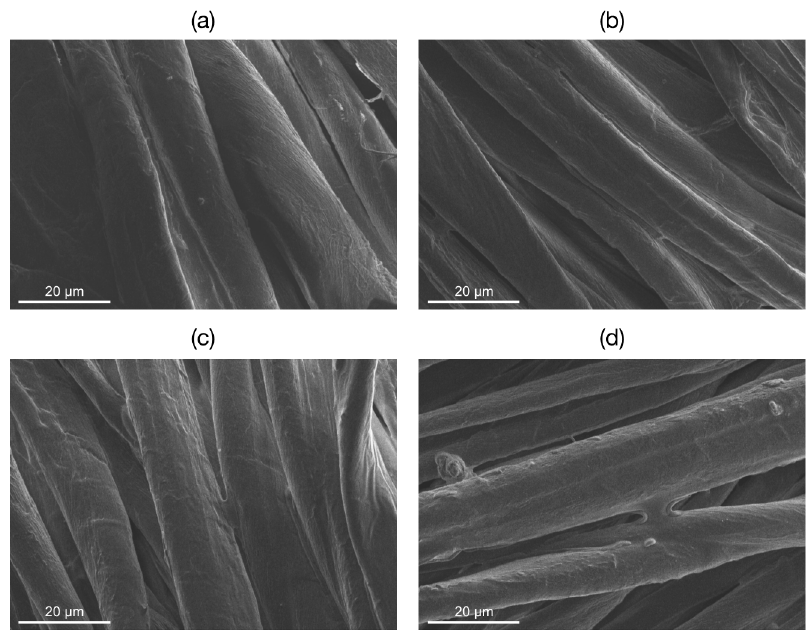
Figure 2. Scanning Electron Microscopy (SEM) images of raw cotton ( a ); Cotton-NBB6h ( b ); Cotton-NBB16h ( c ) and Cotton-NBB80h ( d ). Images were acquired at the same level of magnification.